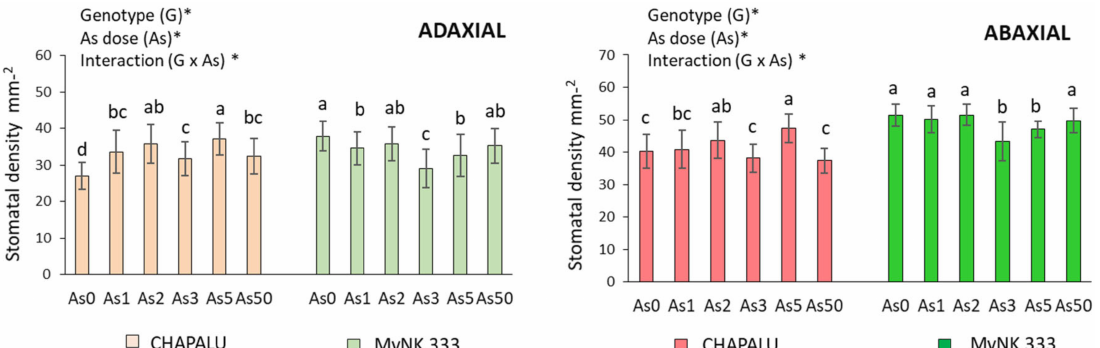
Figure 3. Effect of arsenic on stomatal density in adaxial and abaxial side of leaves of two cultivars of maize. Data are presented as means ± SD from three biological replicates (n = 45). As0, As1, As2, As3 and As50—arsenic addition to soil in mg kg − 1 . The differences between variants of the experiment were determined using the Kruskal–Wallis test followed by Dunn’s post hoc test for multiple comparisons. Different letters on the top of bars indicate a significant difference ( p < 0.05) between variants of the experiment for each cultivar. Data were also examined using two-way ANOVA with the factors As dose (As), genotype (G), and interaction (G x As). *—significance at 0.05